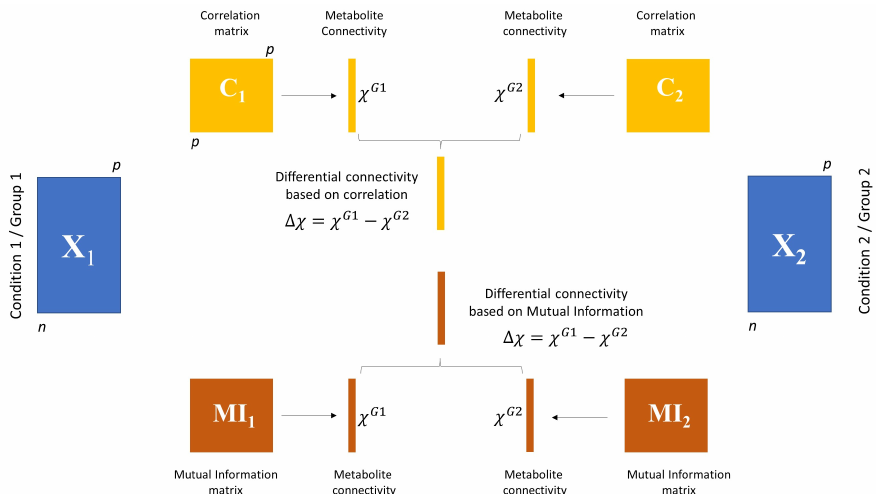
Figure 2. Graphical illustration of differential connectivity analysis. Given two data sets X 1 and X 2 of size n 1 × p and n 2 × p with n 1 possibly different from n 2 , weighted association matrices are built using either correlation ( C 1 and C 2 , for X 1 and X 2 , respectively) or Mutual Information (MI) ( MI 1 and MI 2 ). Weighted (metabolite) connectivity is then calculated as described in Equation (28) for group 1 and group 2 as χ G 1 and χ G 2 . The differential connectivity is given by ∆ χ i = χ G 1 i i using both correlation and MI. Significance is then assessed using a permutation